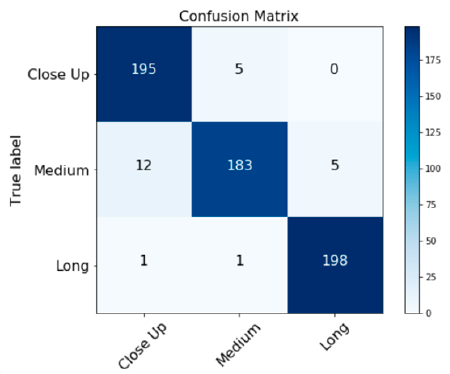
Figure 10. Confusion Matrix of ResNet-50 with Yolact.